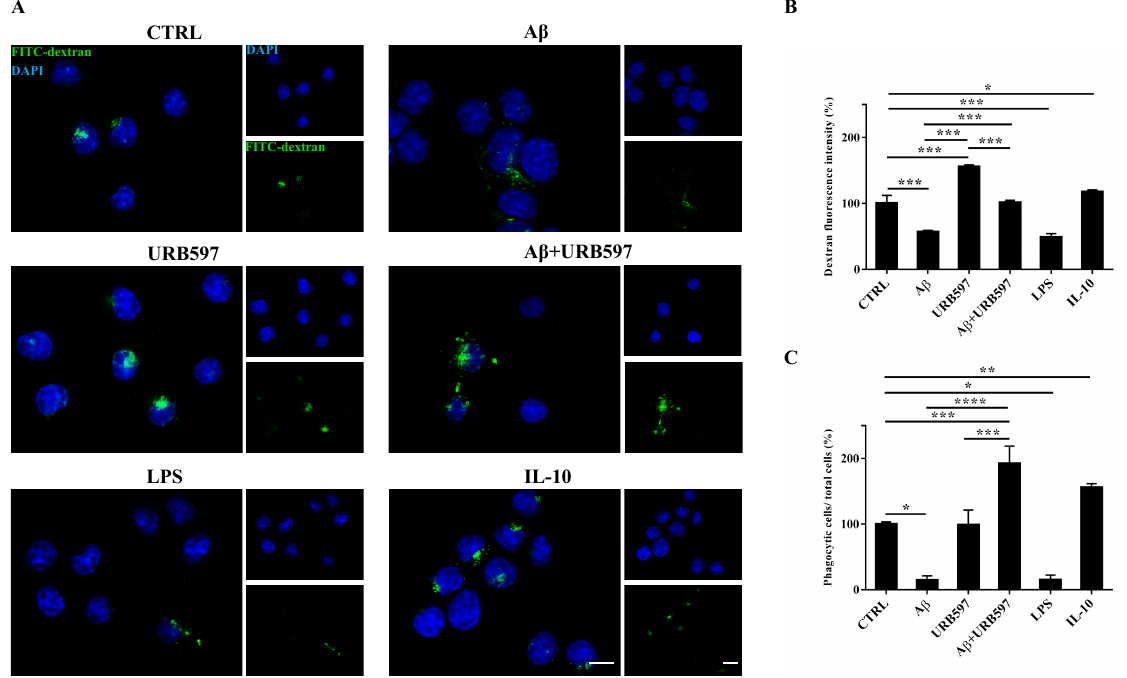
Figure 6. Analysis of the phagocytosis process using FITC-dextran on BV-2 cells pre-treated with 5 µ M URB597 and incubated with 30 µ M A β 25–35 for 24 h. ( A ) Representative immunofluorescence images of FITC-dextran uptake. ( B ) Quantization of the intensity of FITC-dextran. ( C ) Quantization of the number of dextran-positive cells on the total cells. The data were normalized to CTRL and reported as a percentage. The results were expressed as the mean ± SD of three independent experiments. Statistical significance was determined using ANOVA analysis by Tukey’s test. * p < 0.05, ** p < 0.01, *** p < 0.001, **** p < 0.0001. Bar: 20 µm.